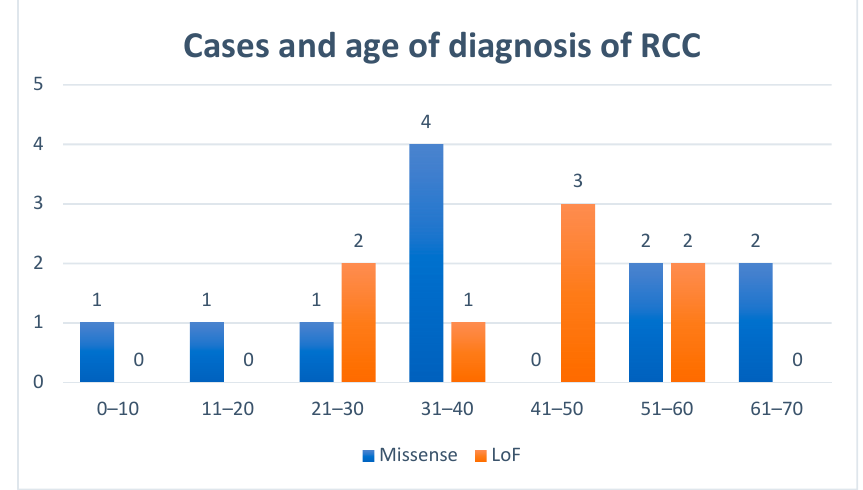
Figure 3. Age at diagnosis of renal cell cancer. RCC, renal cell cancer.